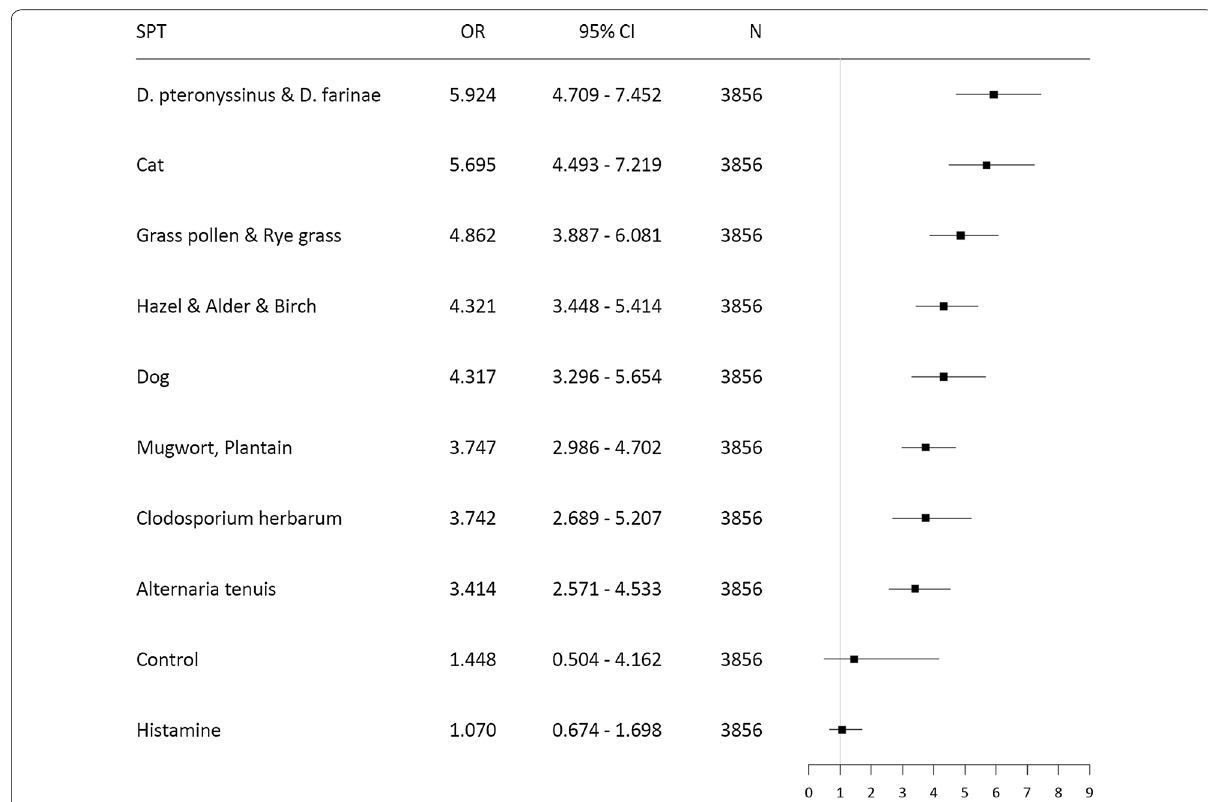
3 mm) for the occurrence of multimorbidity (n ≥ Discussion